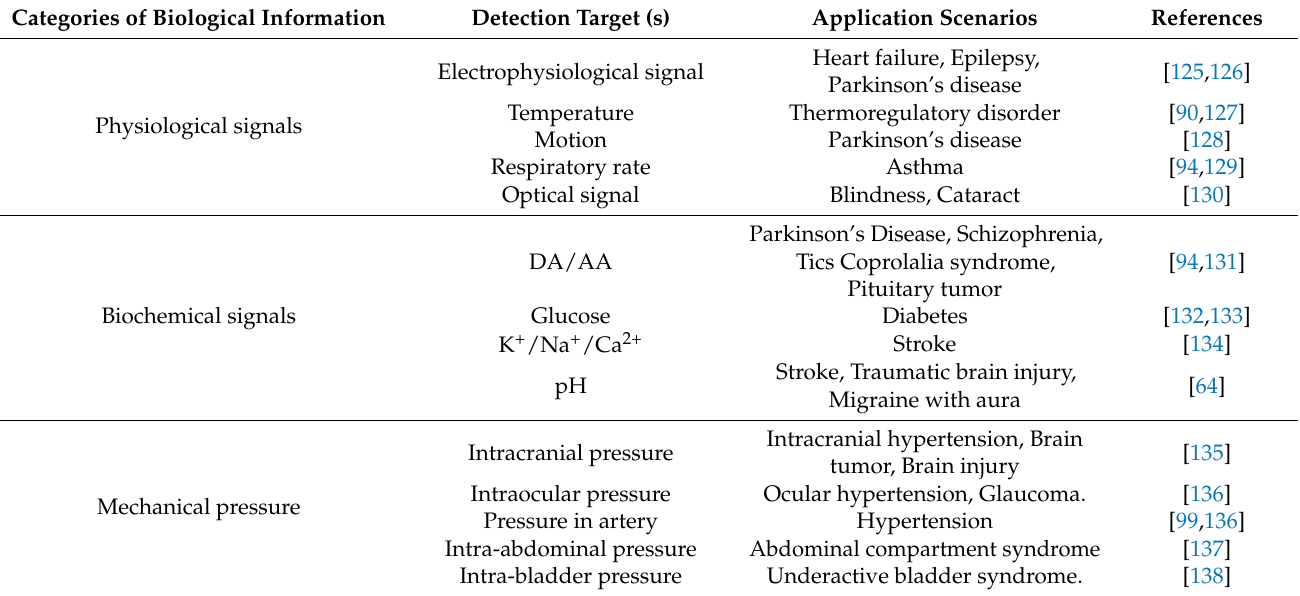
Table 4. Summary of indicators in implantable